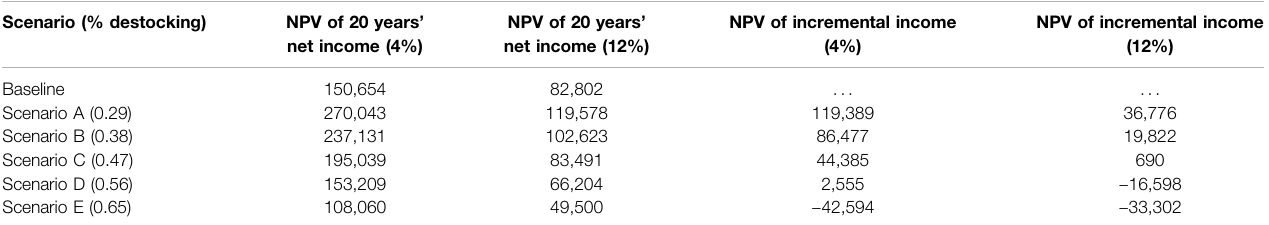
TABLE 5 | Net present value (NPV) of net income and incremental net income over 20 years for the representative household in the baseline and with-project scenarios modeled (Chinese Yuan, CNY). Scenario (% destocking)